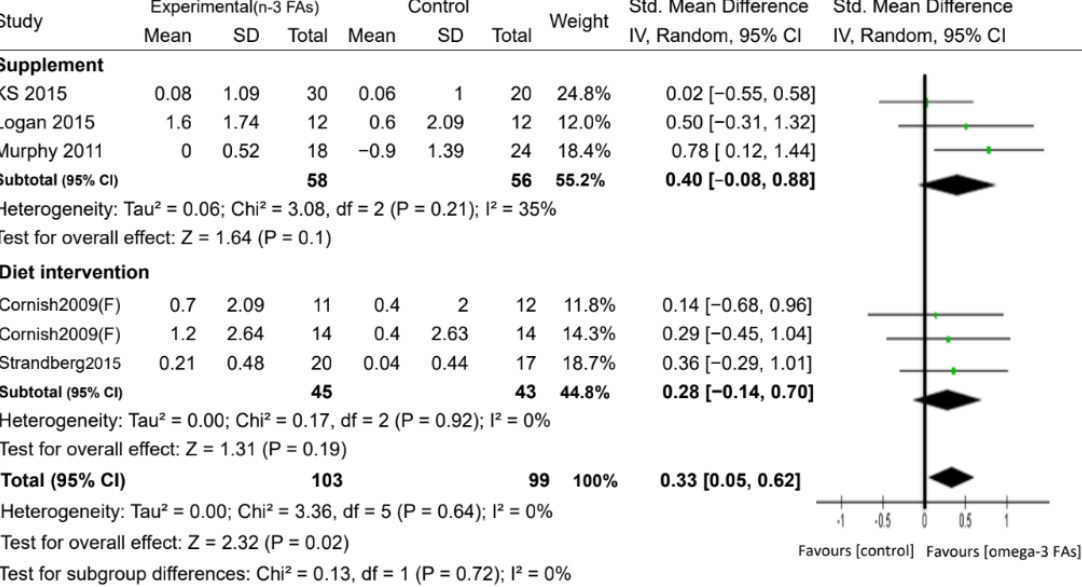
Figure 6. Forest plots of the included studies assessing the effect of n-3 PUFA supplementation on muscle mass categorized by the administration form of n-3 PUFAs. IV: inverse-variance method.